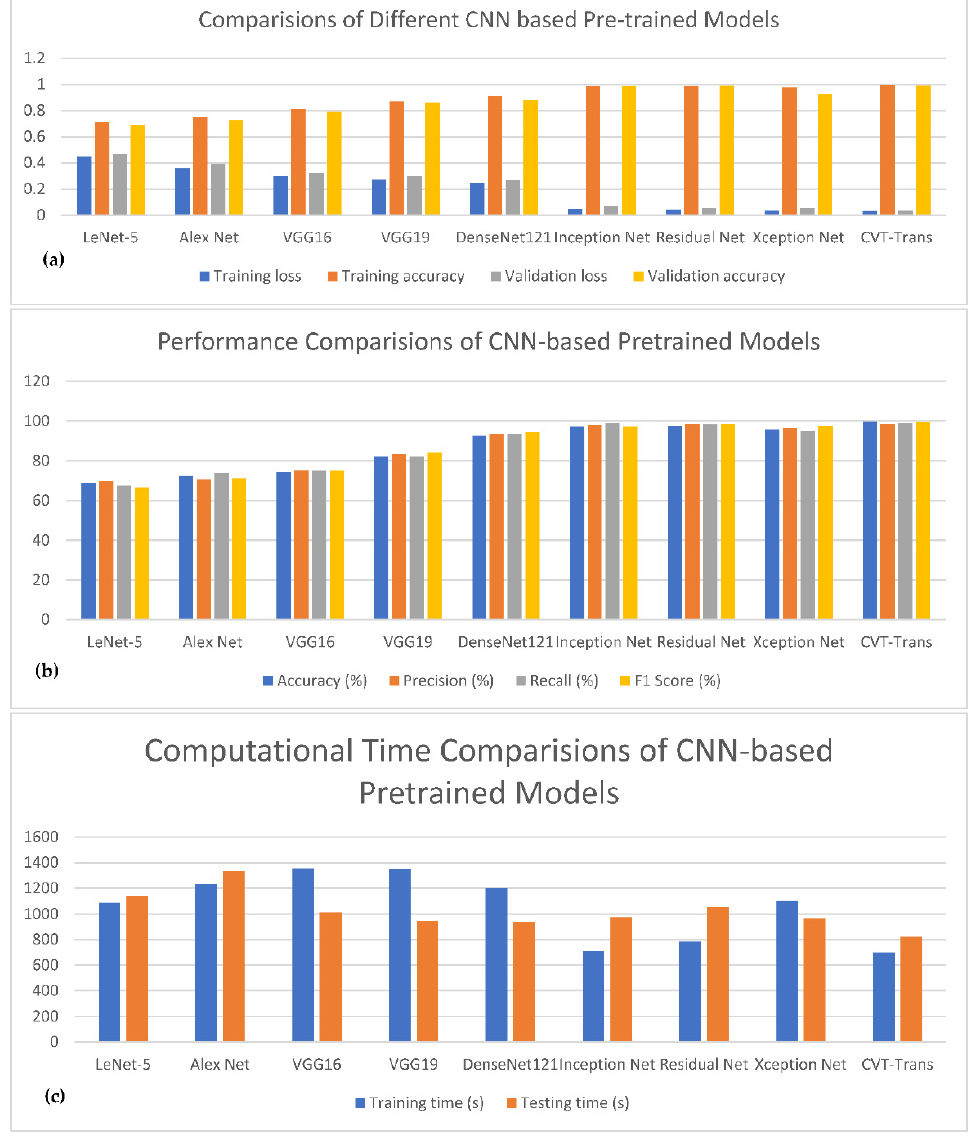
Figure 10. The comparisons of different CNN-based pretrained models with the proposed CVT-Trans technique for classification of five categories of cardiovascular disease. ( a ) Testing/Validation/Training loss, ( b ) Performance measures, ( c ) Computation time.